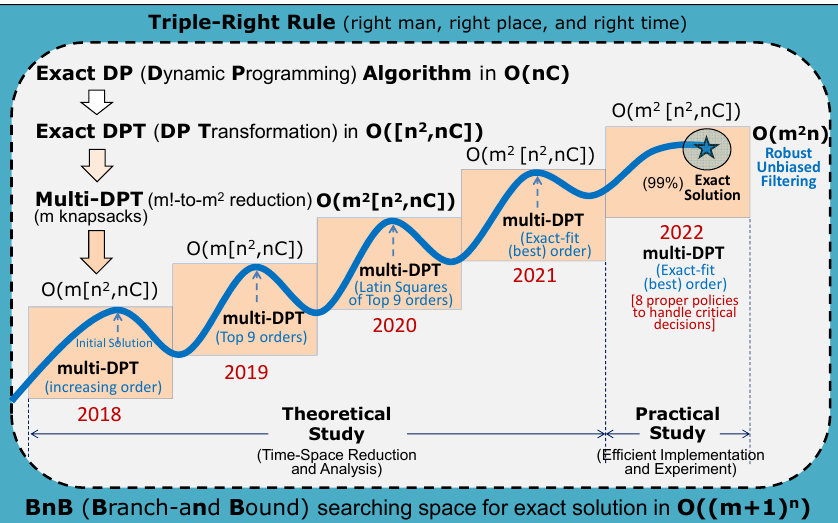
Figure 21. The improvement of our multi-DPT TSR algorithm for solving the 0/1-mKP ( m knapsacks) when dealing with the critical datasets.